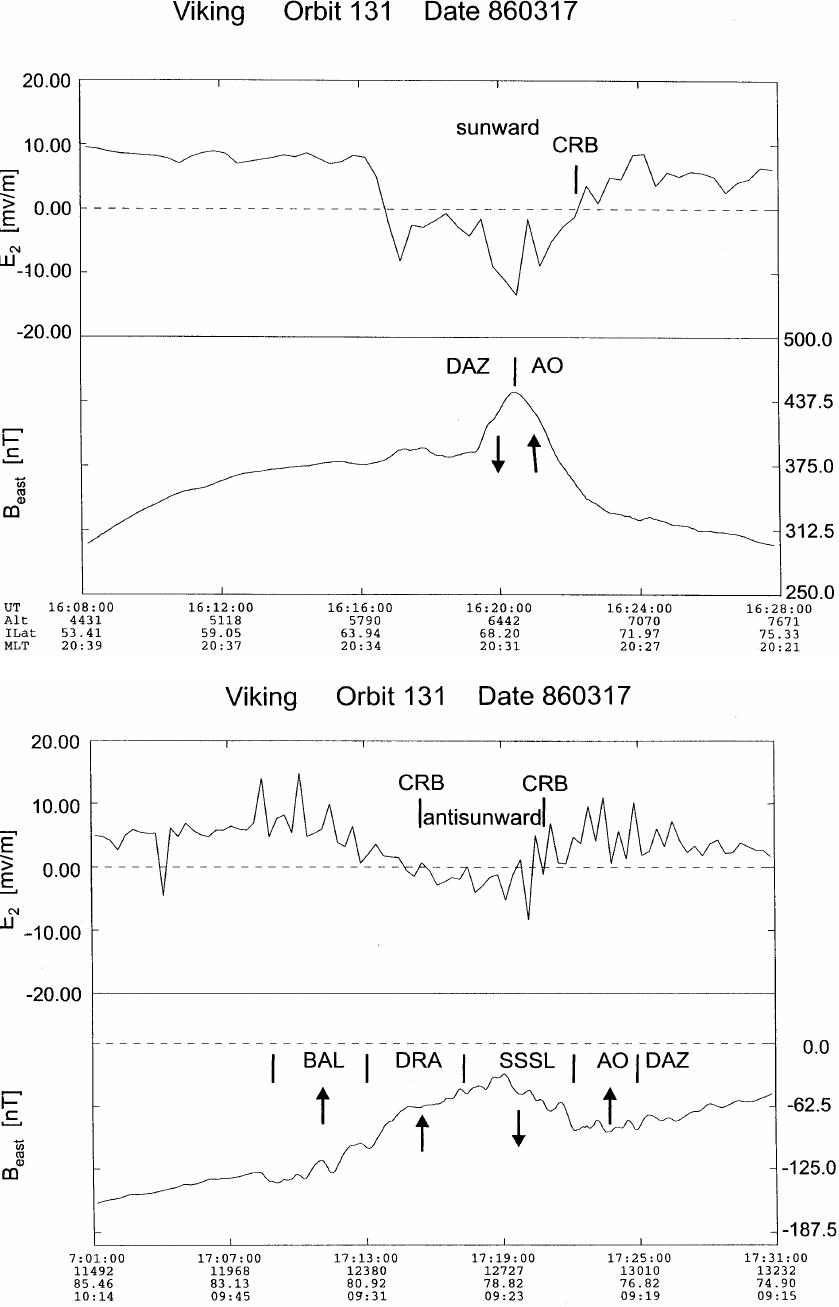
Fig. 7. The east-west component of the Viking magnetometer observations (bottom) and the spin plane compo- nent of the electric field (the compo- nent along the spaccraft trajectory, top) for the pass shown in Fig. 1: (a) the evening sector, (b) the pre-noon sector. The plasma regimes intersected by the satellite and directions of the FACs are marked at the